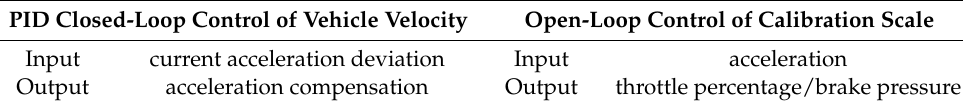
Table 1. Longitudinal control strategy.